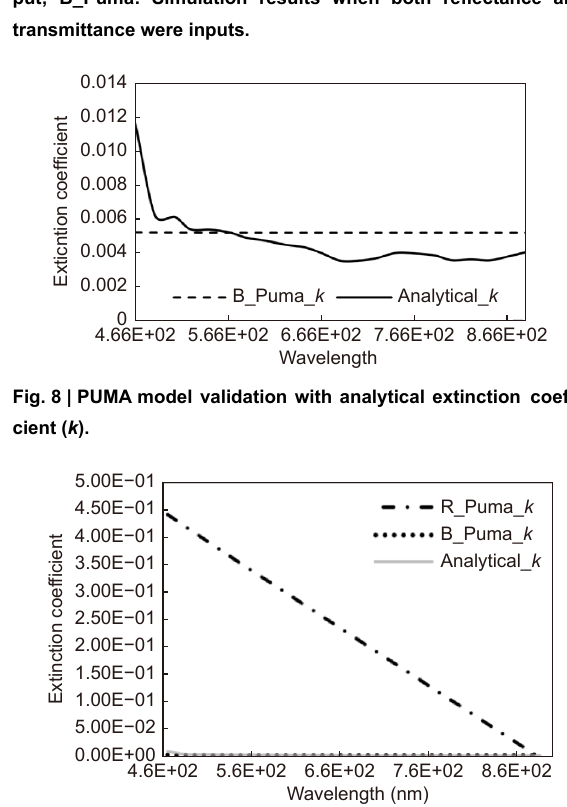
Fig. 9 | PUMA model validation with analytical extinction coeffi- cient ( k ).